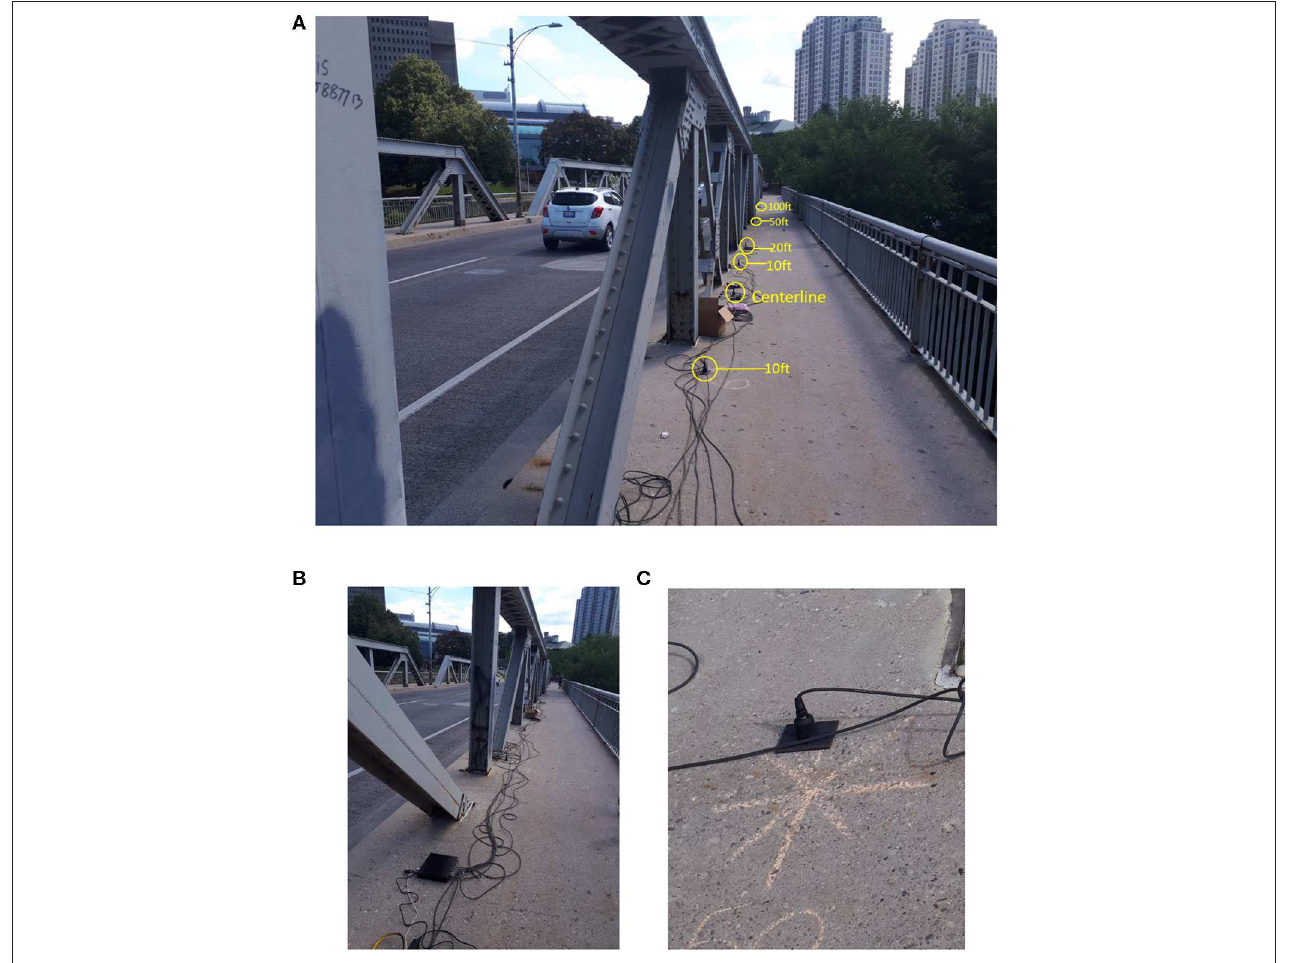
FIGURE 5 | (A) Sensor instrumentation of steel bridge in London, Ontario, (B) data acquisition system, and (C)